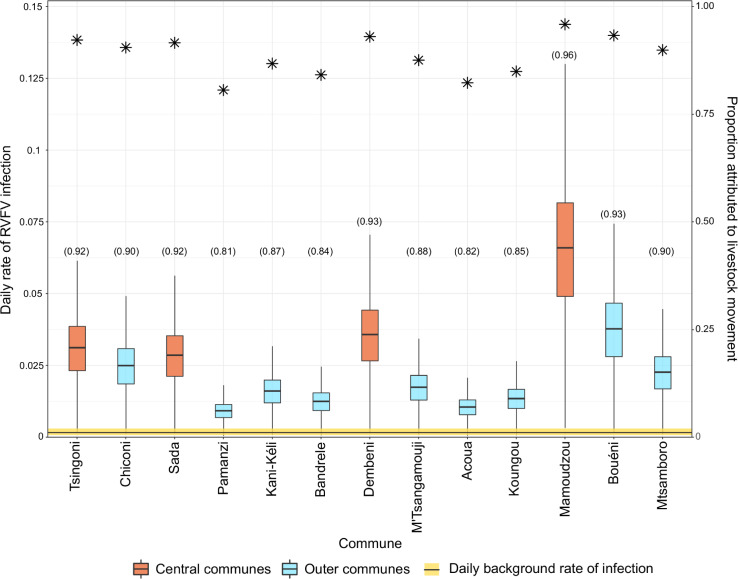
Daily rate of infection per commune estimated from the best livestock movement model.It shows the results of the weighted, time-independent and time-lag livestock movement model. Boxplots show the posterior distributions of the daily rate of infection from livestock movements (red and blue boxplots) and the background daily rate of infection (yellow horizontal bar) on the observed infection day of each commune. Asterisks represent the proportion of simulations where RVFV introduction into a commune was due to livestock movements rather than other routes (i.e. background risk) (y-axis). Numbers in brackets along x-axis labels correspond to the proportion of iterations in which the daily rate of RVFV infection exerted by livestock movements on each commune on the day they reported their first livestock case was greater than the background daily rate of infection.